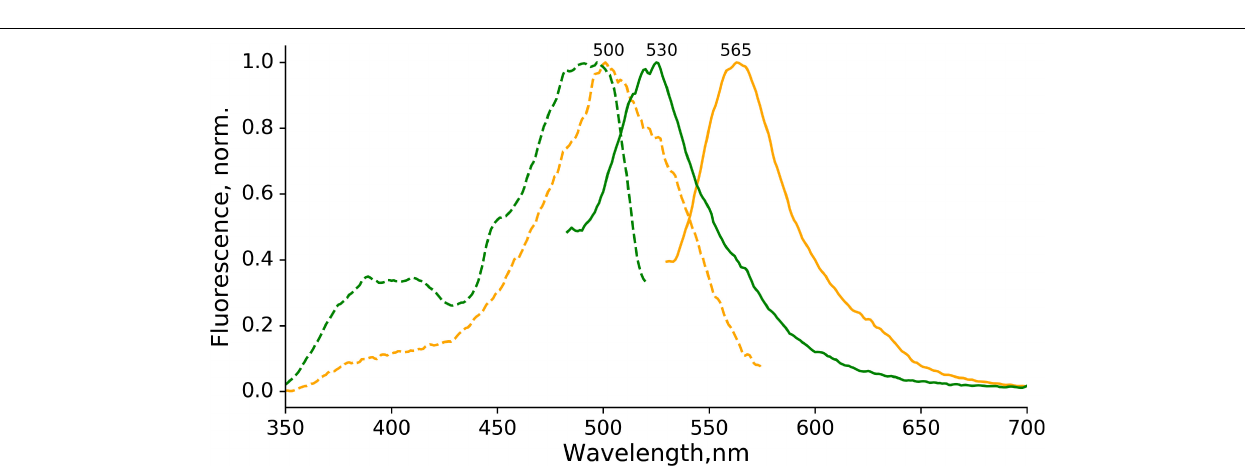
FIGURE 5 | Photoconversion of EGFP-T65G in the presence of sodium dithionite. Orange form: excitation (dashed line, emission at 600 nm) and emission (solid line, excitation at 500 nm) spectra immediately after photoconversion). Green form: excitation (dashed line, emission at 600 nm) and emission (solid line, excitation at 400 nm) spectra immediately after photoconversion). The conditions for photoconversion are similar to the ones used for